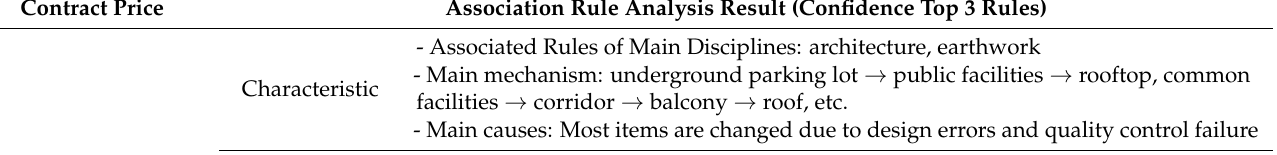
Table 7. Comparison of the results of deriving the rules related to the design changes by project conditions—contract price.